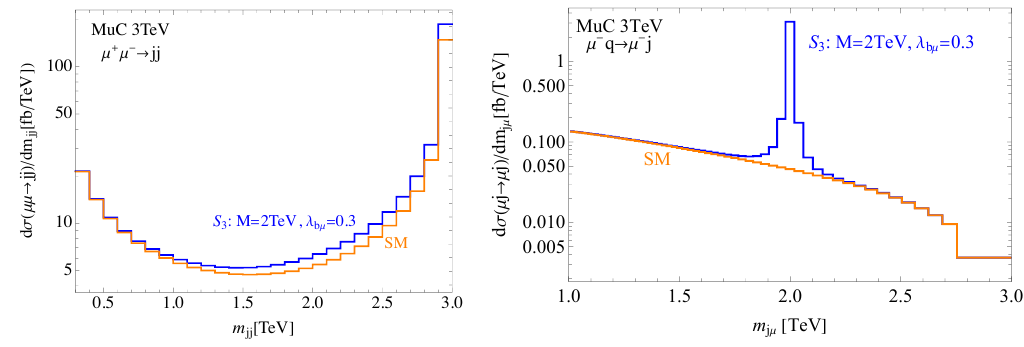
Figure 4 . Differential cross sections for inclusive µ + µ − → jj (left) and µ − q → µ − j (right) for a 3 TeV MuC. The SM cross section is shown in orange, while the prediction for the S 3 resonance with m S = 2 TeV and coupling λ bµ = 0 . 3 is shown in 3